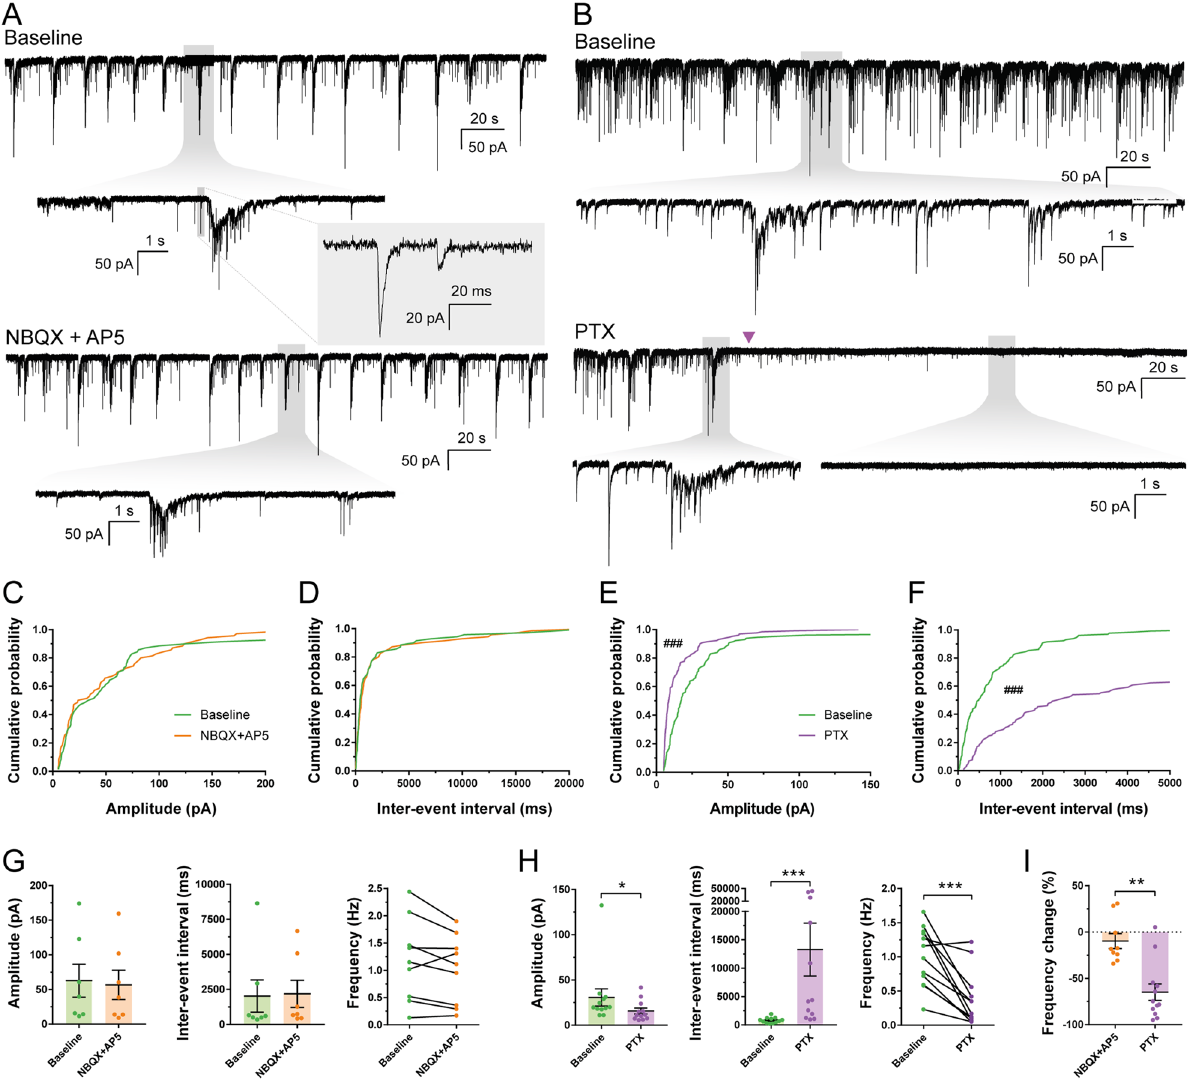
Figure 3. Spontaneous synaptic currents recorded in hdINs are GABAergic. hdINs exhibited spontaneous synaptic currents at 35 and 49 DIV ( A , B ). These spontaneous currents were reduced or abolished by the addition of PTX (1 mM, purple arrow) ( B and E – F ), but were not affected by NBQX (5 µM) and AP5 (50 µM) ( A and C – D ). Cumulative probability curves comparing the events during baseline and addition of the drugs for both amplitude ( C for NBQX + AP5, and E for PTX) and inter-event interval ( D for NBQX + AP5, and F for PTX). ( G ) Distribution of the mean amplitude, inter-event interval and frequency for spontaneous synaptic currents recorded from cells during baseline and after the addition of ( G ) NBQX and AP5, or ( H ) PTX. ( I ) Average frequency change after the addition of each drug in comparison to the baseline. Mean ± SEM. Kolmogorov–Smirnov test for cumulative distributions and Mann–Whitney test for comparison of means (NBQX + AP5 n = 7 and PTX n = 14; 10 events per cell and condition). Kolmogorov–Smirnov test: ### p < .0001. Mann–Whitney test: * p < .01; ** p < .001; *** p < .0001; **** p <